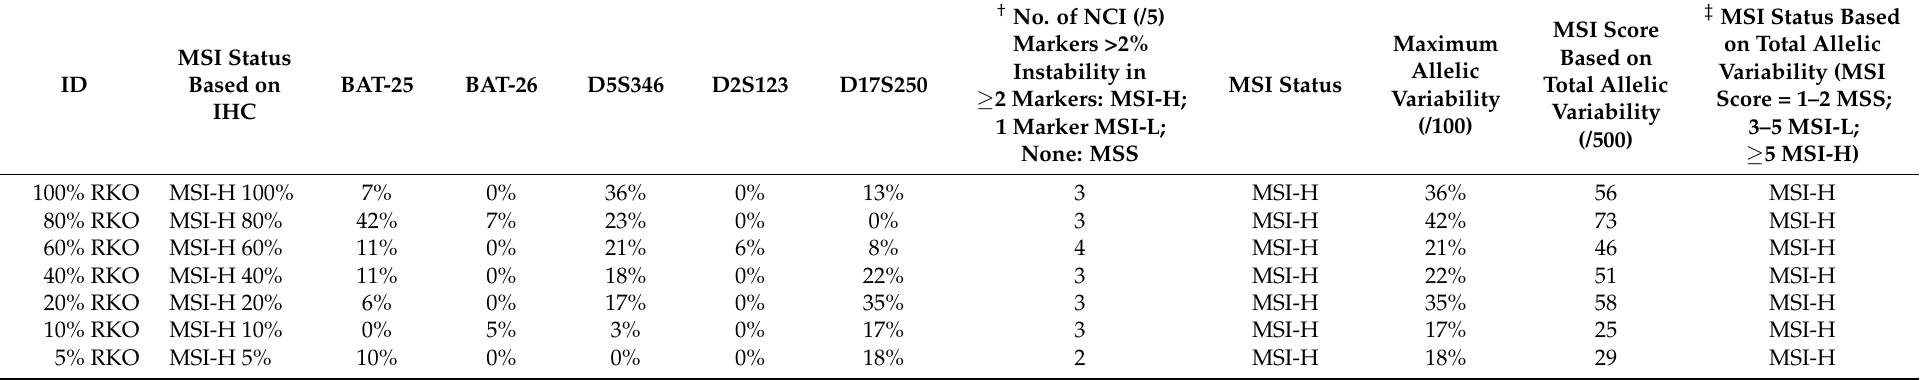
Table 4. Limit of microsatellite instability detection analysis in cell lines. MSI dilution series (5%, 10%, 20%, 40%, 60%, 80%, 100%) using RKO (MSI-H) and HT29 (MSS) cell line